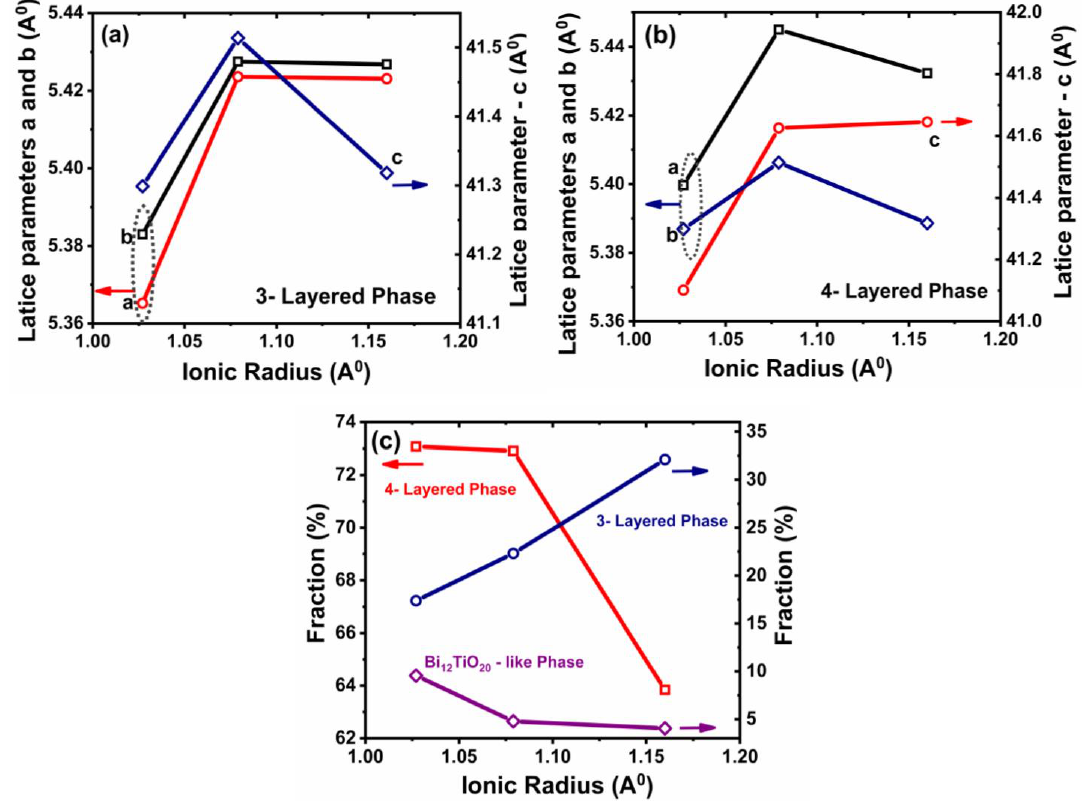
Figure 2. ( a–c ) Lattice parameters of ( a ) 3-layered phase, ( b ) the volume fraction of 3-, 4-layered, and impurity phase Bi 12 TiO 20 phase and ( c ) 4-layered phase with respect to rare earth ion size. From the images, it is evident that spots were observed. The orientation of randomly oriented plate-like morphology is also evident in the SEM images. In addition, a small spot (shown as encircle) of grain-like growth is also seen in the images. This kind of de- tected morphology is attributed to the accumulation of polyhedral phases of impurity phase or Co-Fe segregation at the grain boundary region [8]. The appearance of the sec- ondary- phase affects the grain growth and leads to plate-like morphology with increasing the RE incorporation. The ratio of Fe/Co content found in the elemental analysis, shown in Figure 3d–f, is found to be less than unity. This conforms to the collection of polyhedral grain over the SEM morphology, as shown as a circled region. Based on this observation one can conclude that the presence of pyrochlore formation is mainly due to the mixed value combination of Fe/Co and its ratio.